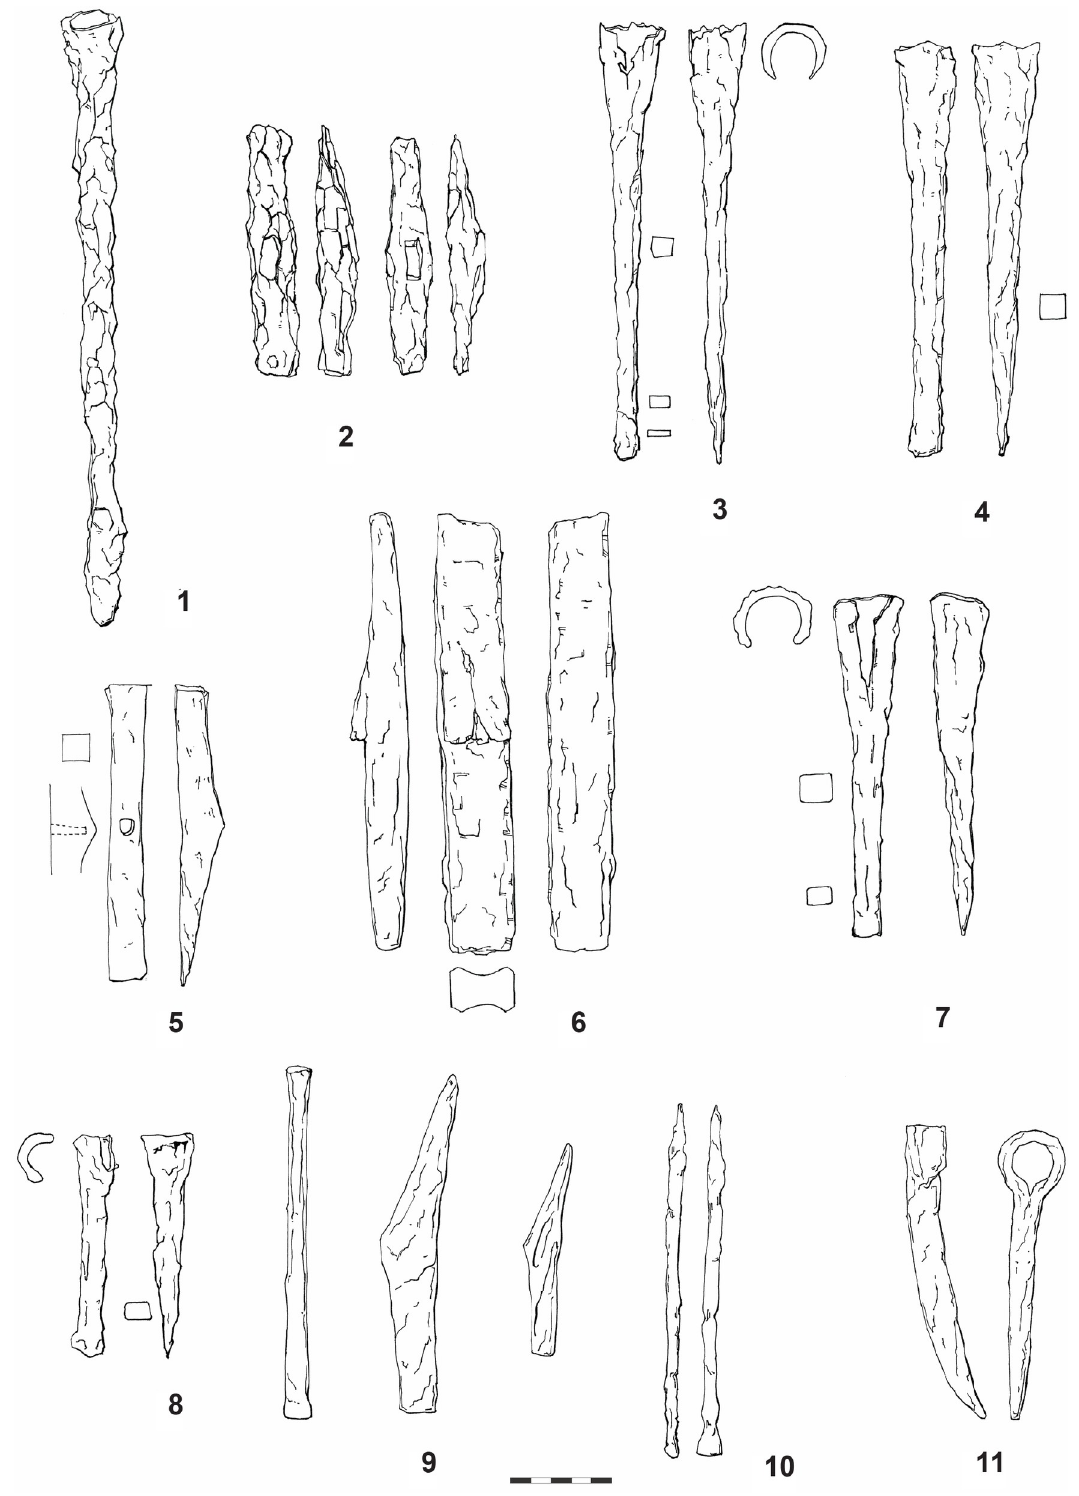
Fig 24. Finds of the corresponding tools from Bohemia: 1–2 Lib č ice nad Vltavou-Chy´nov (after [121], 243); 3–6 Kolı´n (after [117], Abb. 13:1, 17:1–2, 18: 2); 7–8 Č eske´ Lhotice (after [119], obr. 72:3, 6); 9 Stradonice (after [120], obr. 204:1–3); 10 Rˇehnice (after [121], 437); 11 Bezdeˇdovice (after [121], 150–151) (drawing: A. Musilova´).